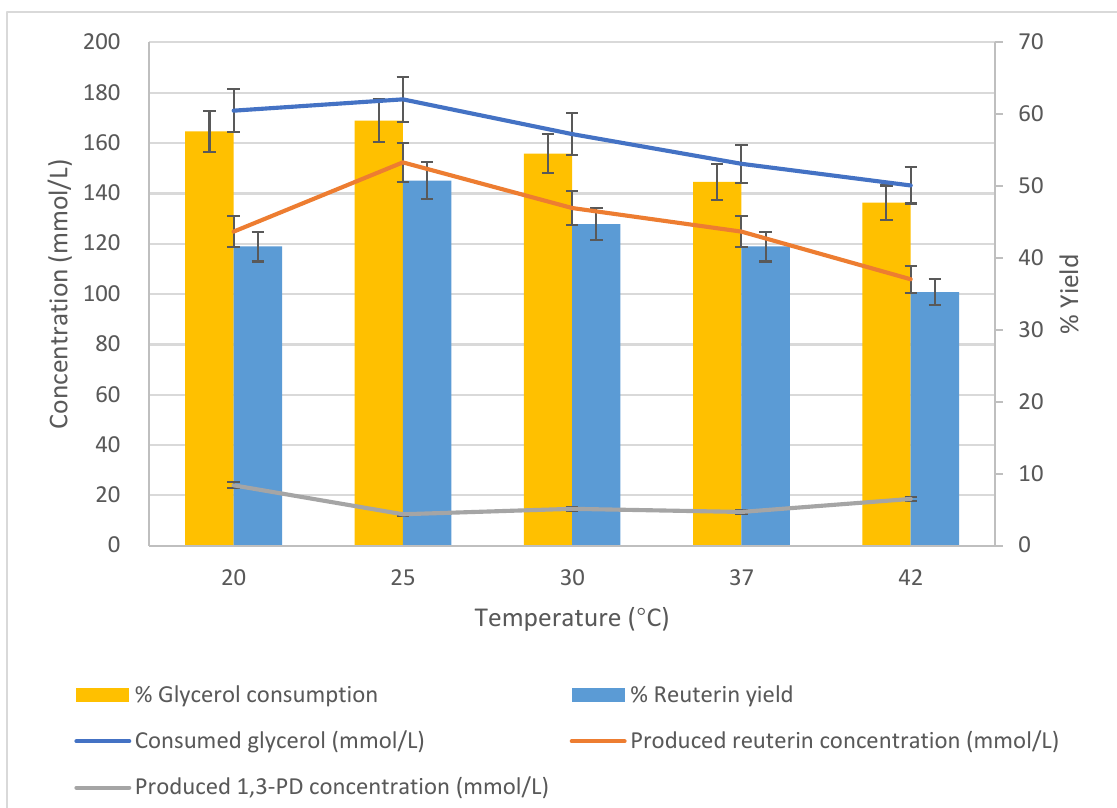
Figure 7. Effect of temperature on reuterin production.